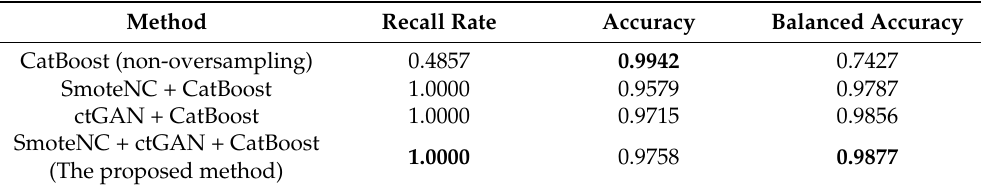
Table 12. Prediction results obtained for the PWF diagnosis using other methods used for processing limited data.